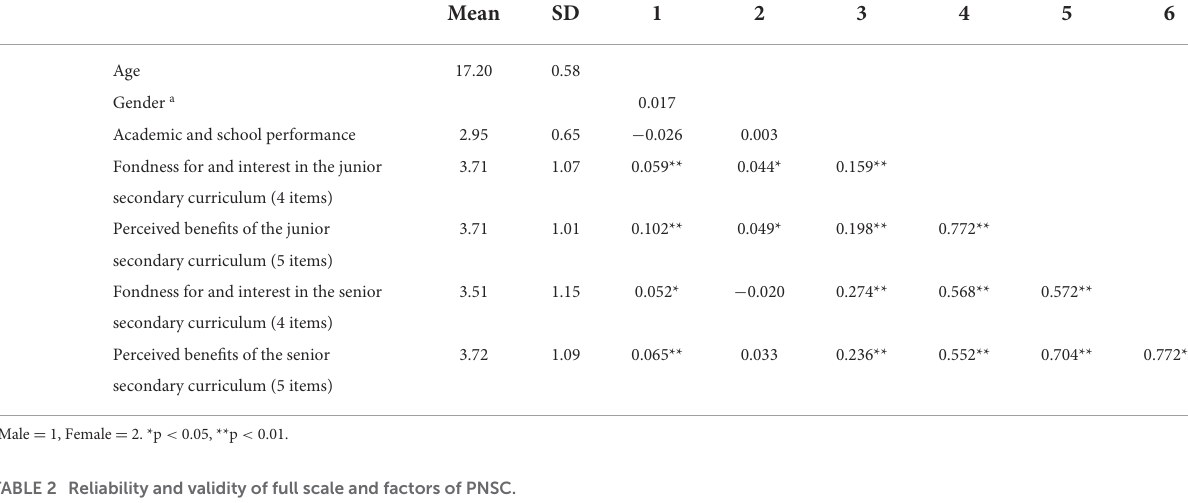
TABLE 1 Results of correlation analysis among research variables.